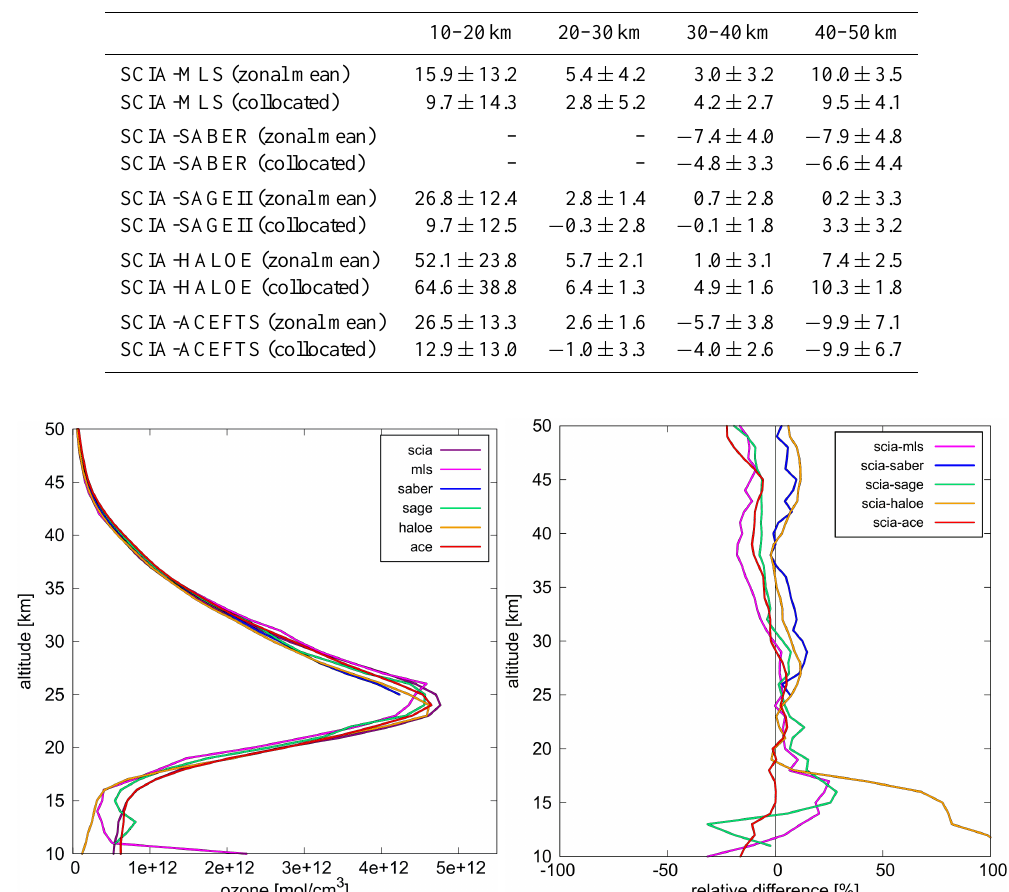
Table 1. Summary of global (60 ◦ S–60 ◦ N) mean percent differences between SCIAMACHY and other satellite data. The difference profiles for zonal mean comparisons and for collocated profile data are shown in Figs. 2 and 3, respectively.